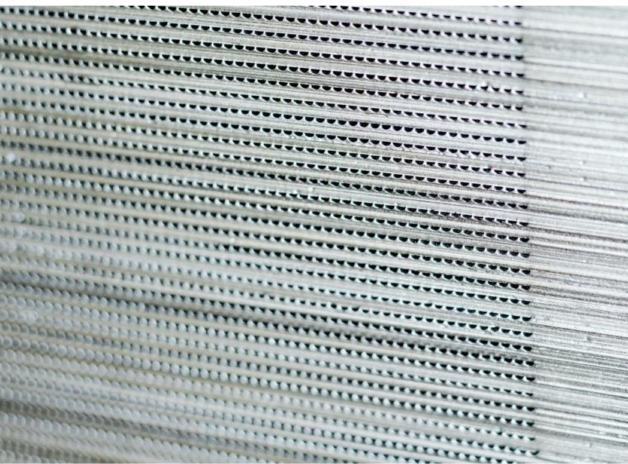
Figure 1. Inside configuration of printed circuit heat exchanger (PCHE)